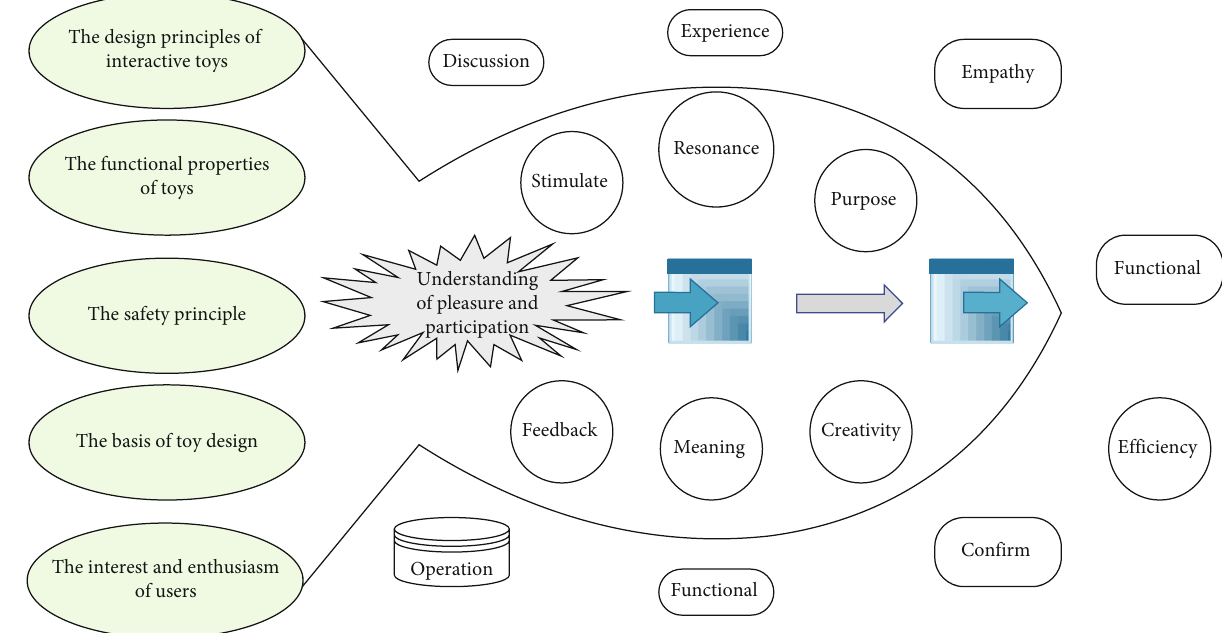
Figure 4: Flow chart of the design of children ’ s vocal